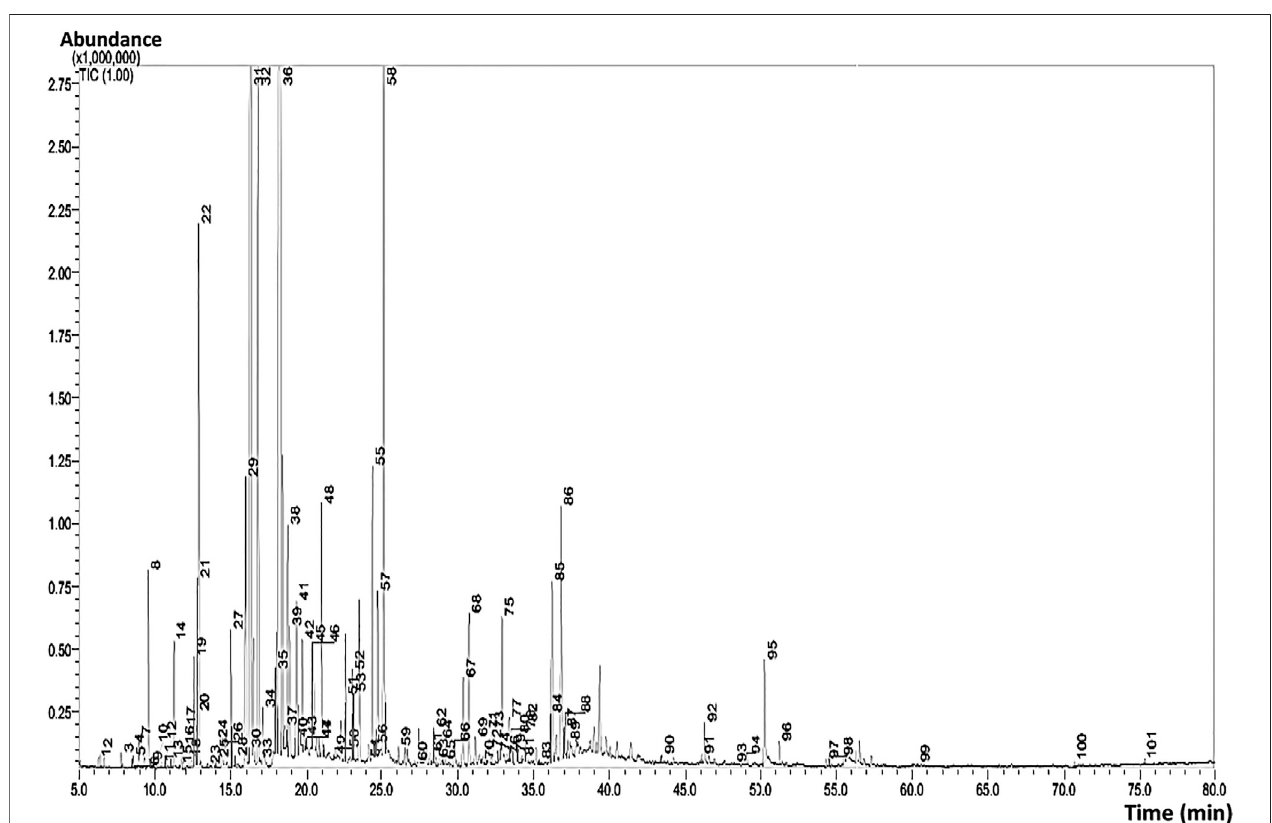
FIGURE 1 | GC/MS chromatogram of the characterized